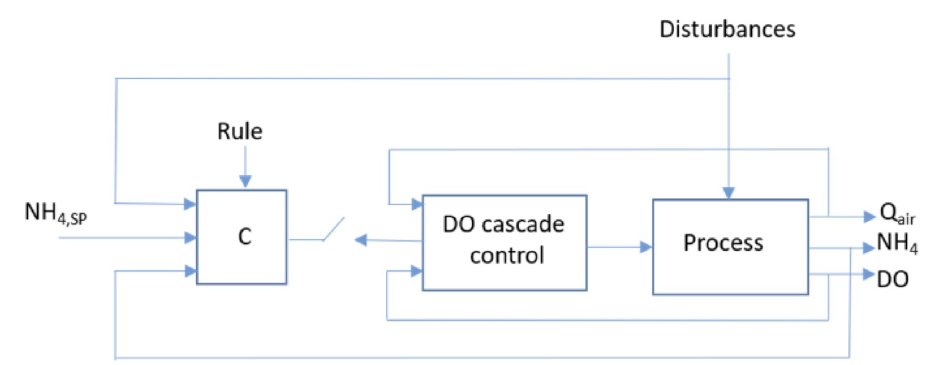
Figure 6. Control of the aerobic volume.